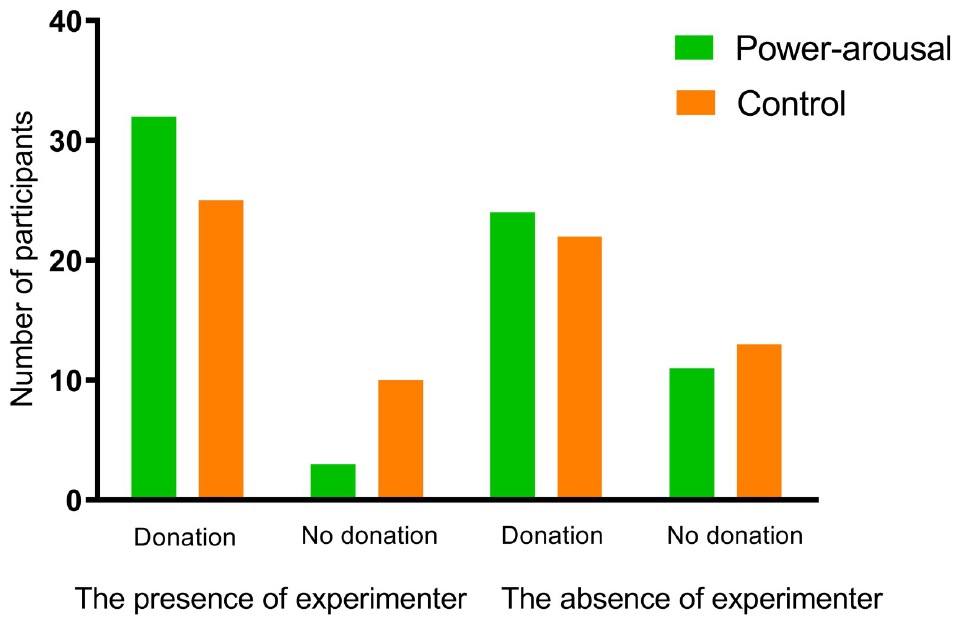
Fig 2. Number of participants from the power motivation arousal and control group who offered/did not offer donation in conditions that the experimenter present or not present.